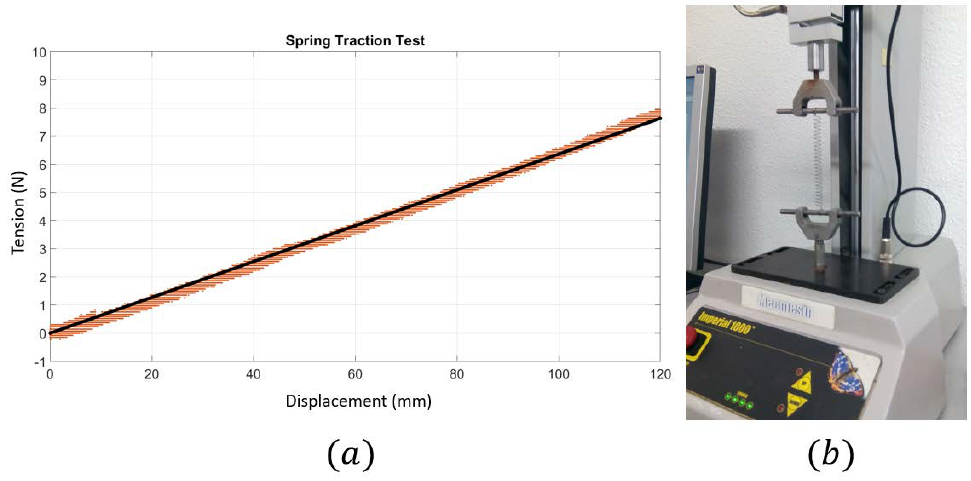
Figure 11. ( a ) Curve of the spring situated as a link between A and C: Tension versus elongation; ( b ) Device where traction test was done: Mecmesh Imperial 1000.